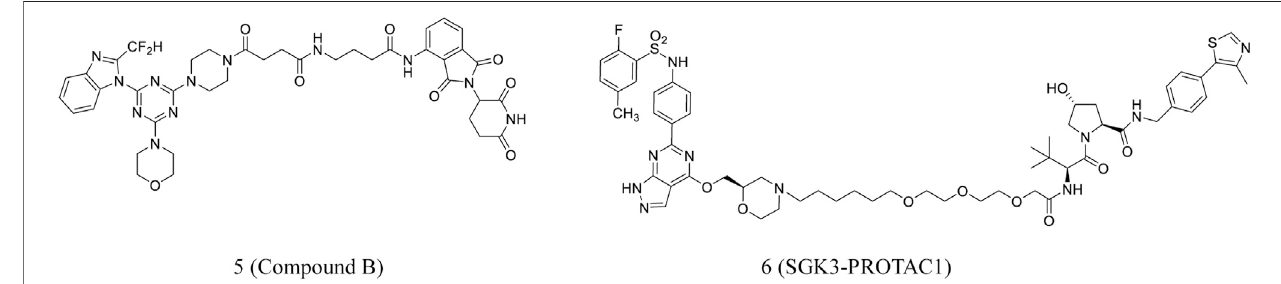
FIGURE 3 | Chemical structures of PROTACs targeting